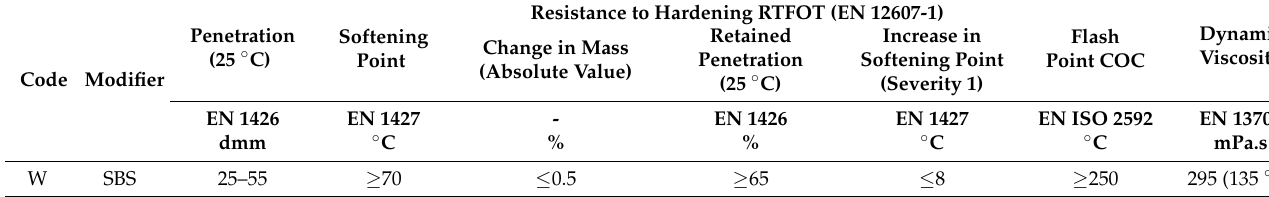
Table A5. Typical Bitumen values.